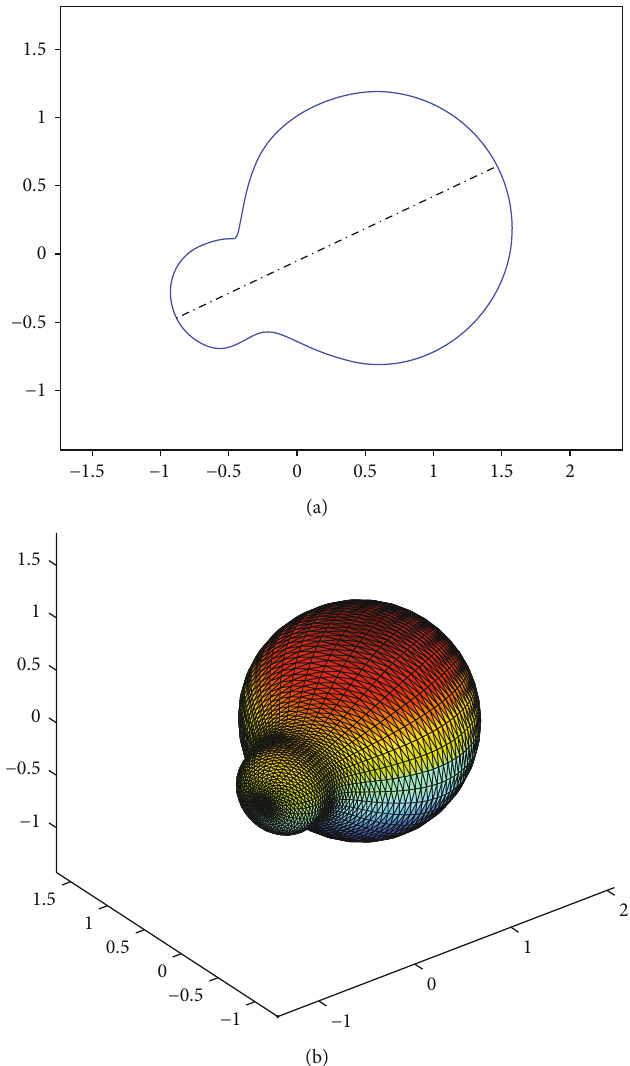
Figure 3: From contour to 3D surface using axis-symmetric surface of rotation. (a) Contour of bubble and the axis of symmetry. (b) The generated 3D